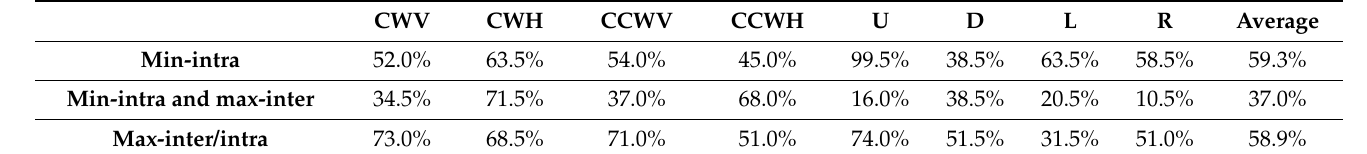
Table 3. Each gesture ’ s recognition accuracy of three DTW template selection methods.